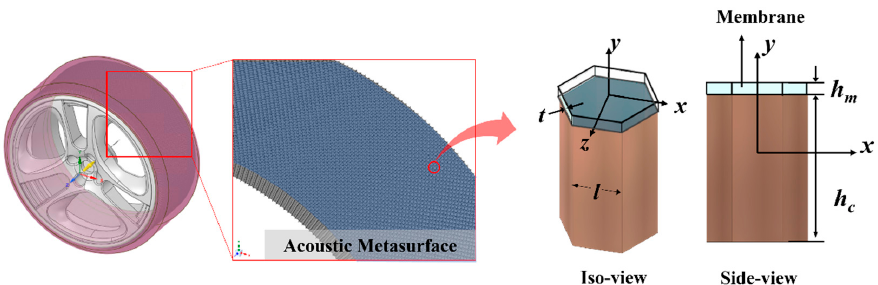
Figure 1. A concept to reduce tire noise with an acoustic metasurface consisting of a honeycomb core panel and a soft, thin plate on the tire ′ s rim.